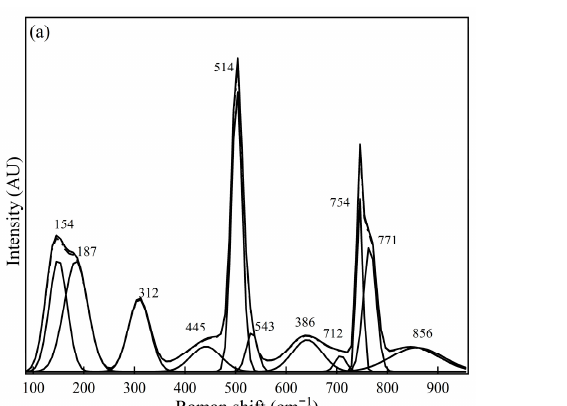
Figure 2. Raman spectra for Sample #1 were measured using ( a ) spot measurements and ( b ) sample rotation (using the rotating stage).